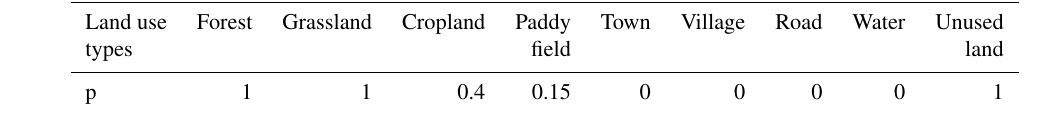
Table 2. Soil and water conservation factors in Yinjiang County.